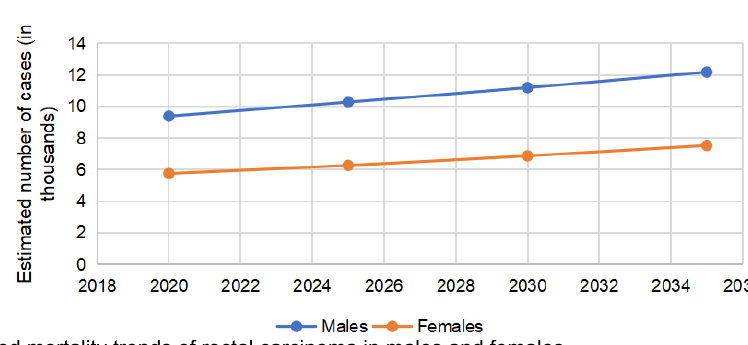
Figure 4. Predicted mortality trends of colorectal carcinoma in males and females